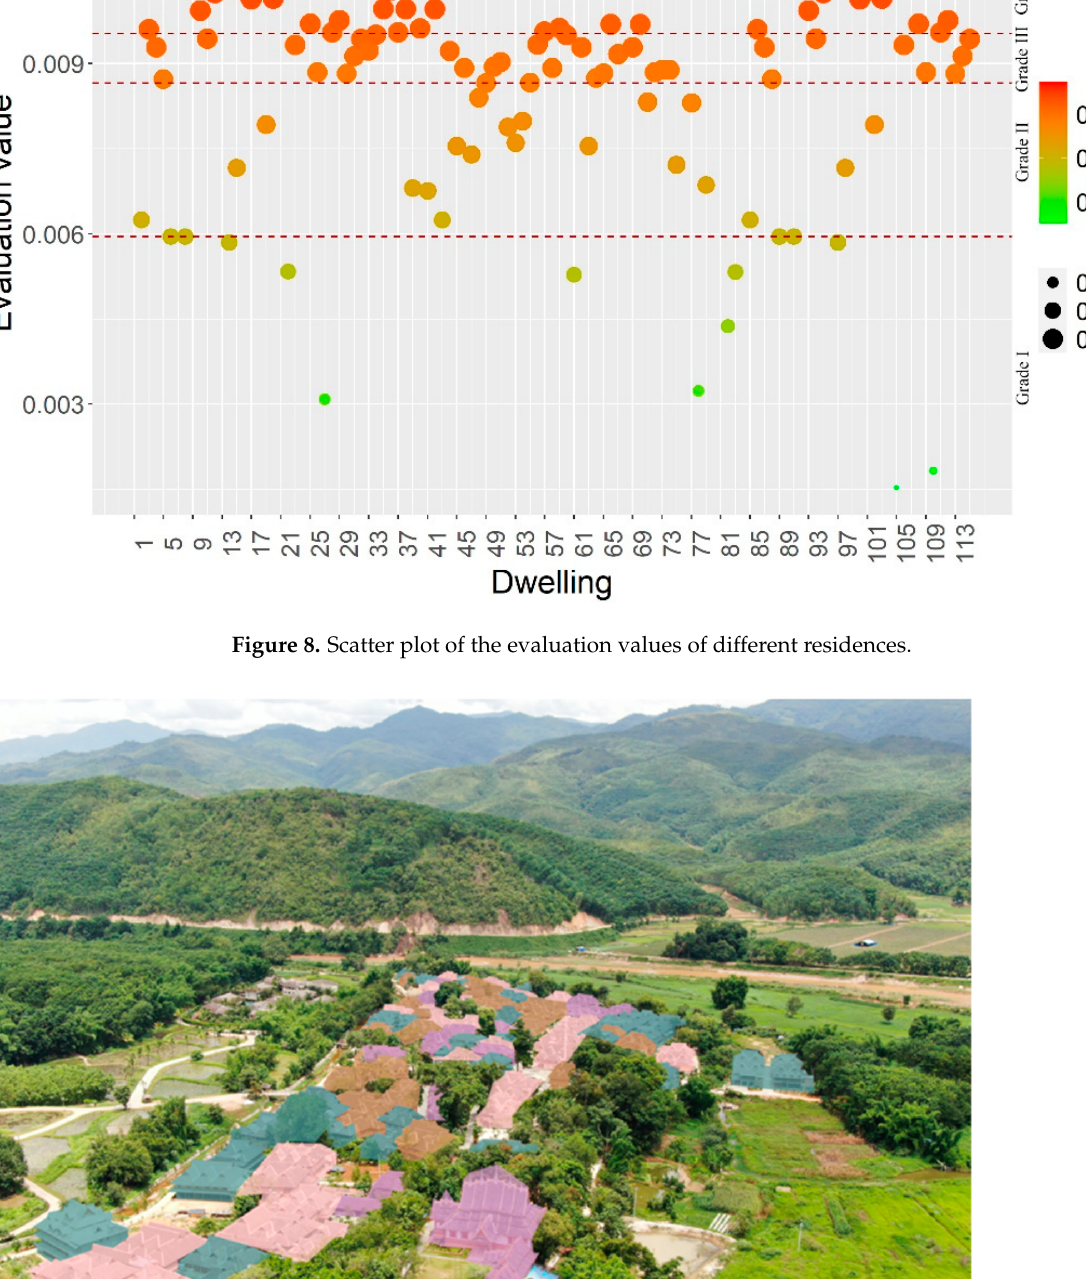
Figure 9. Distribution of residential grades in Mengjinglai village.